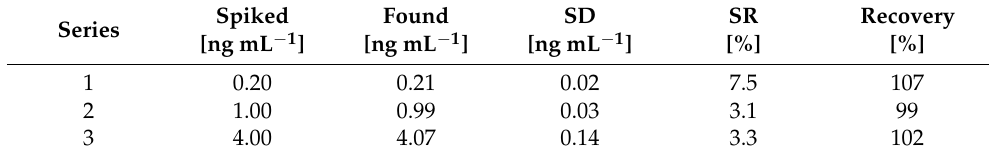
Table 2. Precision and recovery of cortisol determination with the developed immunosensor ( n = 24). Spiked Series [ng mL − 1